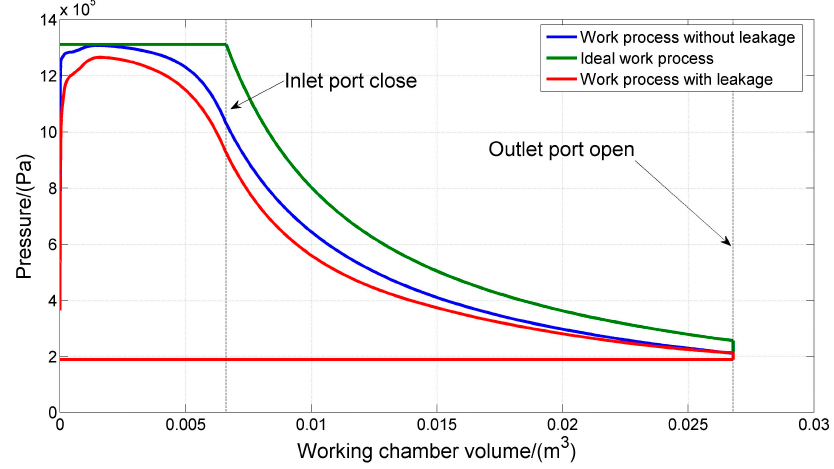
Figure 8. P - V diagram of ideal and simulated work process ( P i = 1.3 MPa, T i = 192 °C, m t = 20 t/h, P o = 0.19 Mpa, n = 2400 rpm).